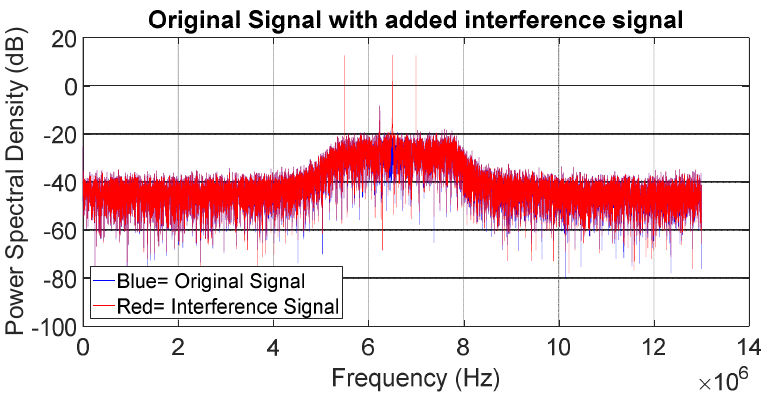
Figure 16. Frequency spectrum of the raw sampled RF front-end data with added 4 CW interference at J/No = 40 dB-Hz and freqj = 5.5, 6.5, 6.5033, and 7 MHz.